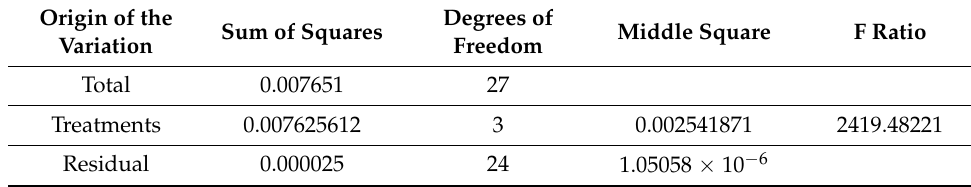
Table 7. ANOVA analysis.